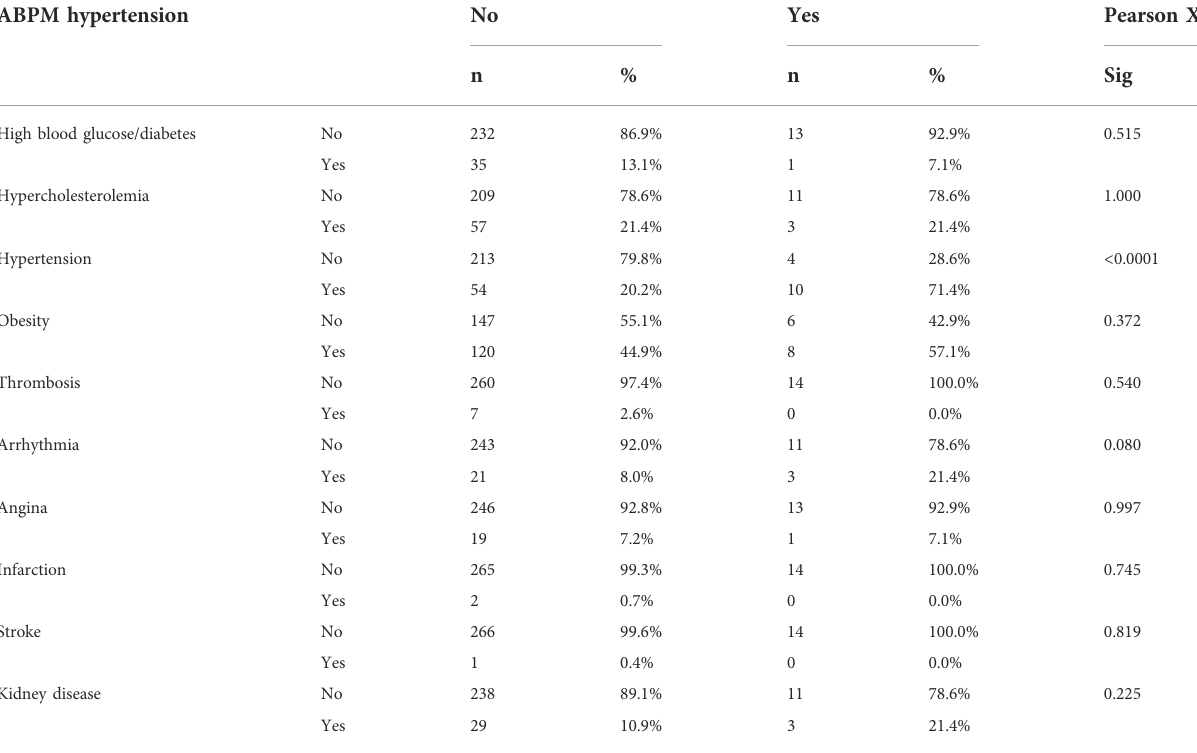
TABLE 3 Evaluation of the presence of hypertension (ABPM) according to the patient ’ s self-reported